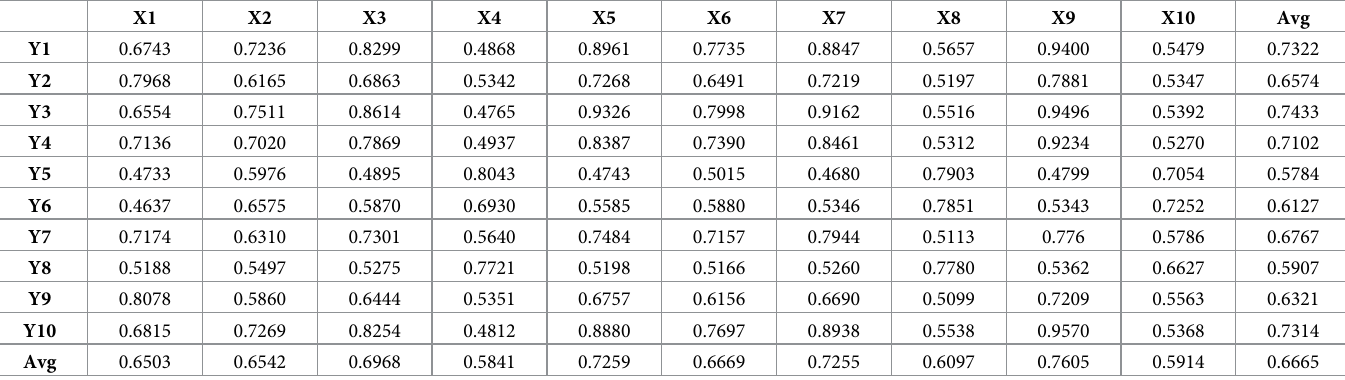
Table 7. Matrix for the coupling effect of cold chain logistics and